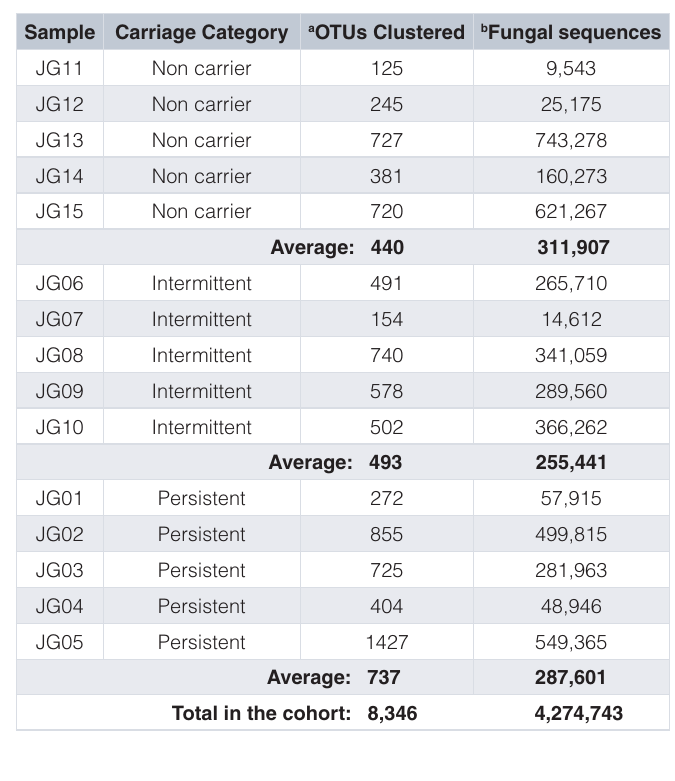
Table 3. Number of fugal sequences and OTUs from medical students with known Staphylococcus aureus carriage